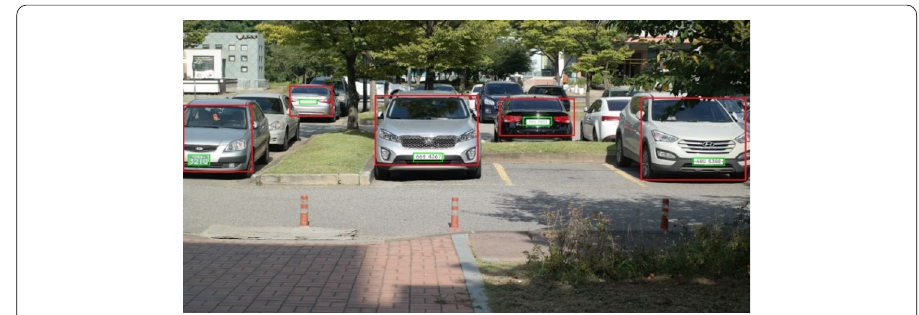
Fig. 6 Detection results of the proposed method